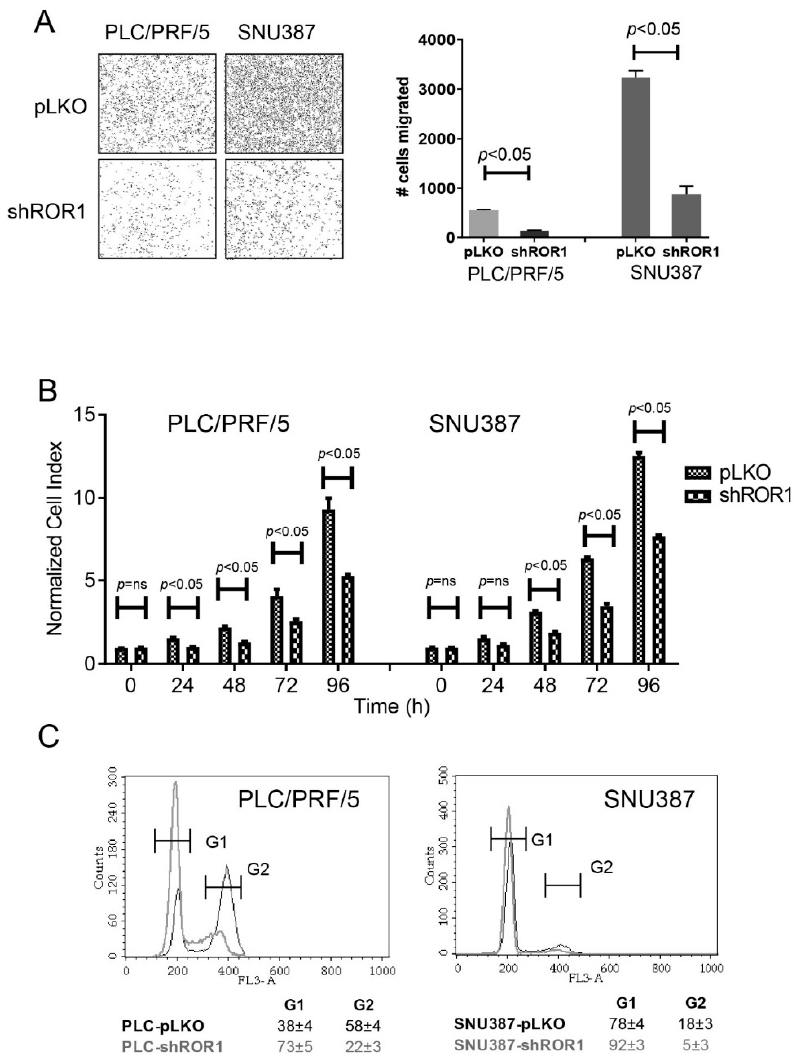
Figure 5. Analysis of cell cycle, proliferation, and migration capacities of shRNA ROR1-knockdown and control clones. ( A ) ROR1-knockdown and control clones were seeded into insert chambers of transwell plates and were allowed to migrate for 48 h. The number of migrated cells were counted by using ImageJ analysis of stained insert membranes. ( B ) Proliferation of ROR1-shRNA knockdown and control clones was analyzed by xCELLigence real-time cell analysis (RTCA) systems. Proliferation of cells was represented as a normalized cell index. *** p < 0.001. ( C ) Propidium iodide DNA staining was used to analyze the cell cycle state of ROR1-knockdown and control clones of SNU387 and PLC cells by flow cytometry.